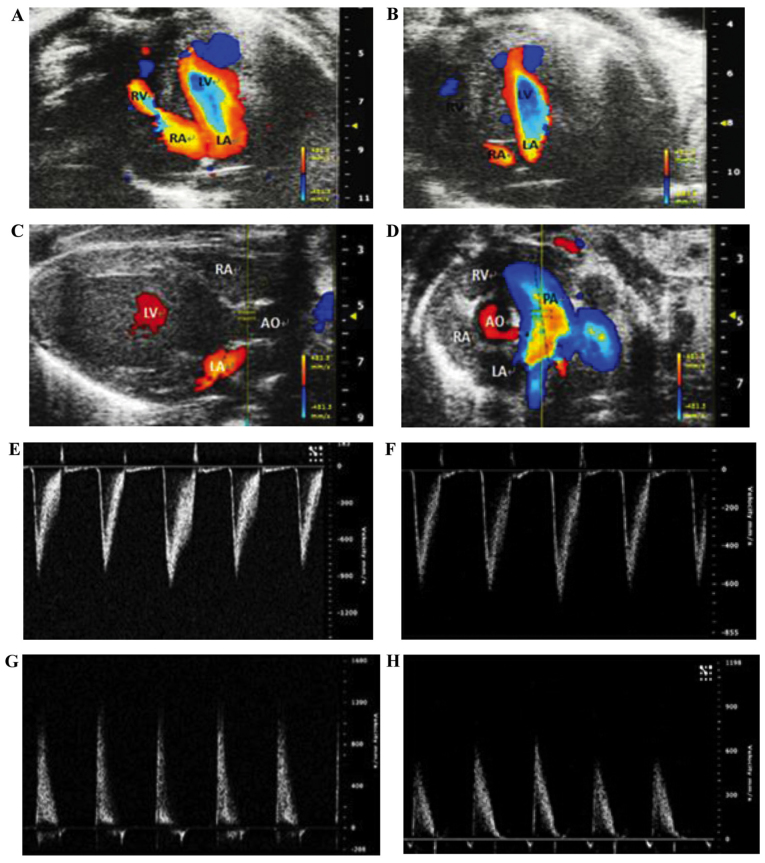
Echocardiography showing an atrial septal defect (ASD) in the heterozygous transgenic mice: (A–D) color Doppler echocardiographic images; and (E–F) pulsed Doppler echocardiographic images. (A) An apical four chamber view of the heterozygous mouse heart, displaying the blood circulation between the atria. (B) An apical four chamber view of the wild-type mouse heart, with no obvious abnormality. (C and D) Images of pulmonary valve peak velocity of the heterozygous transgenic mouse and its wild-type littermate, respectively. (E and F) The pulsed Doppler echocardiographic images across the pulmonary valves of the heterozygous transgenic mouse and its wild-type littermate, respectively. (G and H) The pulsed Doppler echocardiographic images across the aortic valves of the heterozygous transgenic mouse (G) and its wild-type littermate (H). RV, right ventricle; LV, left ventricle; RA, right atrium; LA, left atrium; AO, aorta.